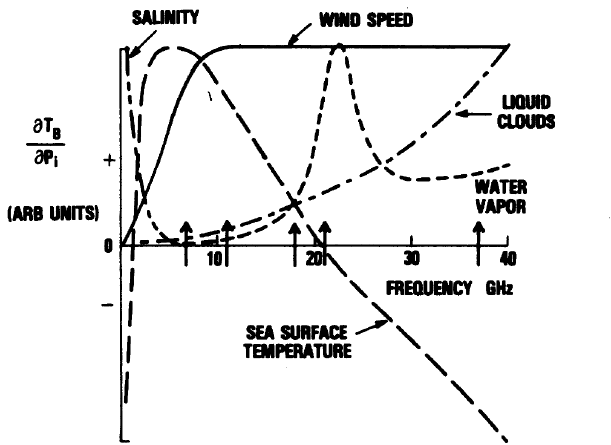
Figure 1. Figure 3 in Wilheit (1979). Schematic superposition of the spectra of various geophysical parameters, P i . The arrows indicate SMMR frequencies. The signs have been chosen to be positive in the frequency range of primary importance to the given